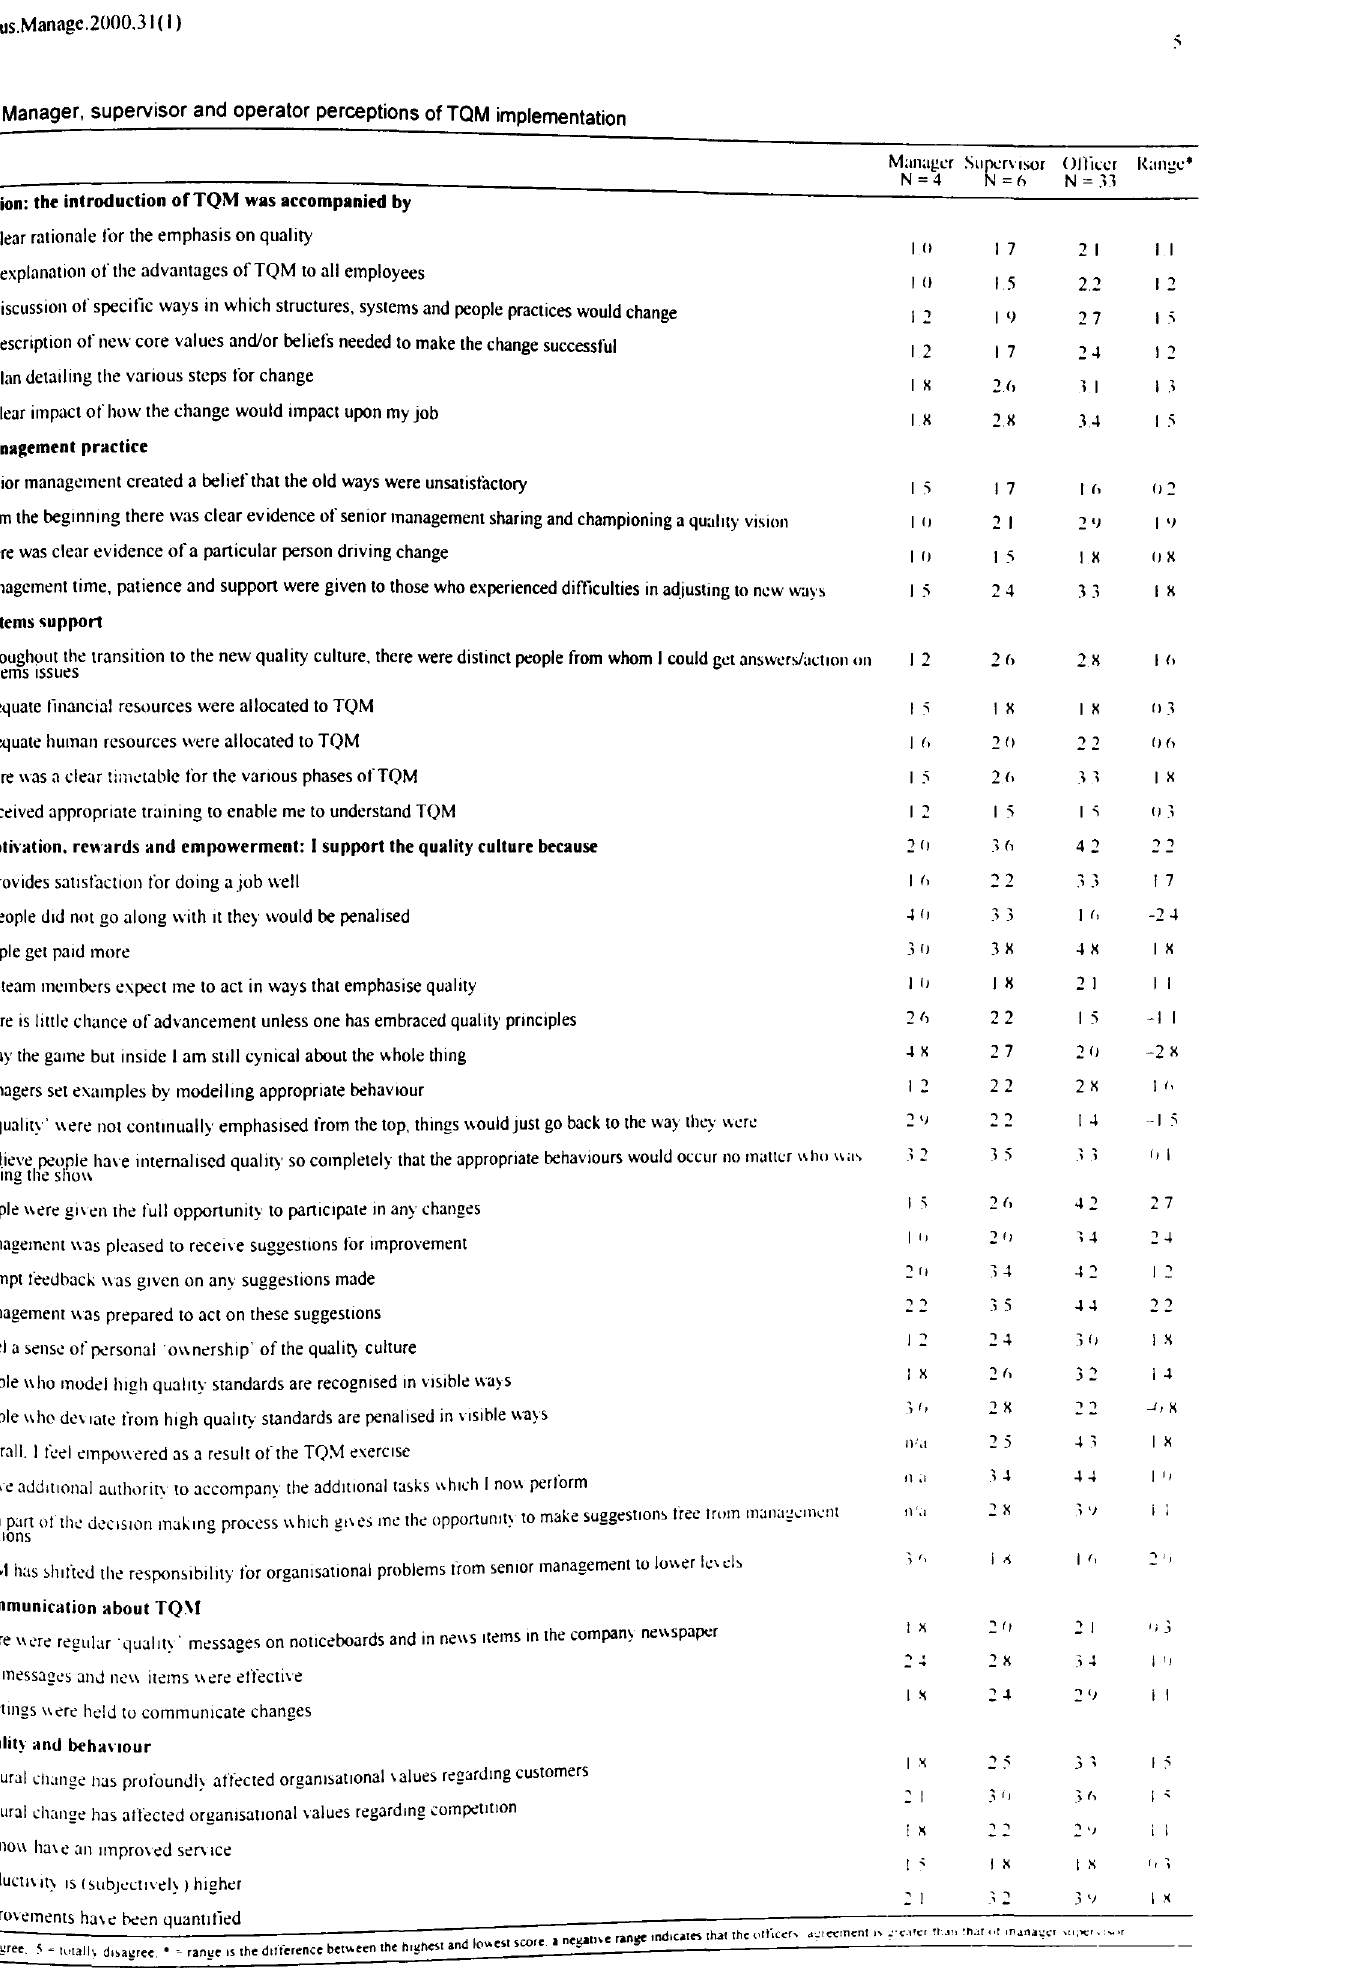
Table 1 Manager, supervisor and operator perceptions of TQM